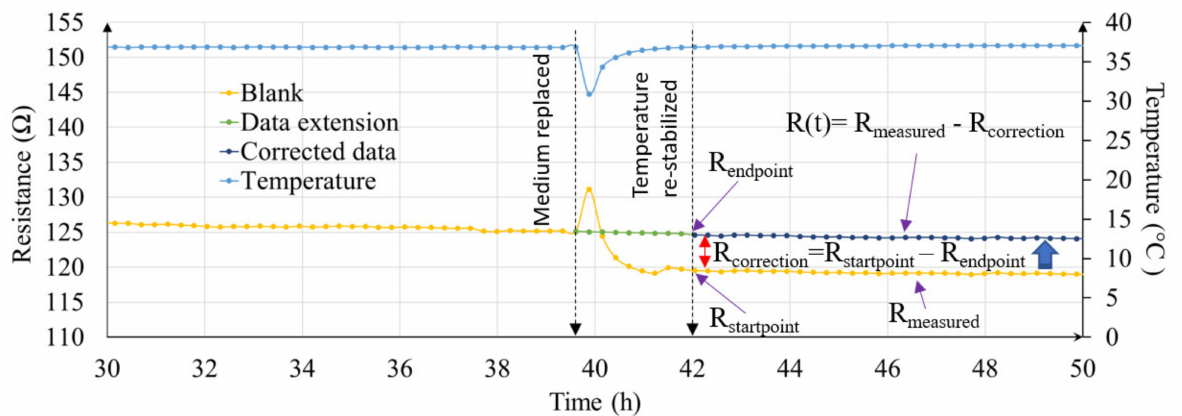
Figure 6. Graphical illustration showing influence in resistance after medium change process and procedure used to correct the data offset. Only “blank” data (t = 30 h to t = 50 h) is plotted for